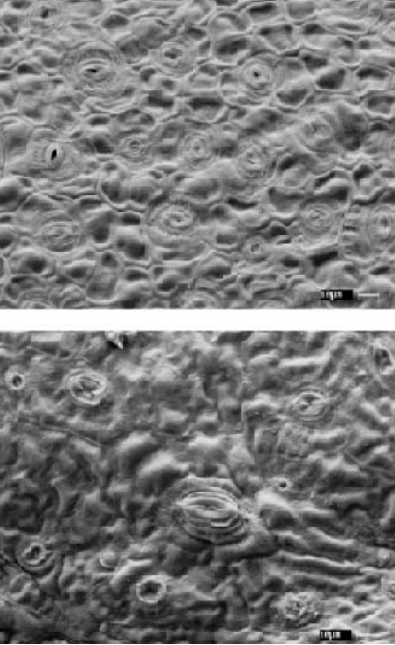
Figure 3. Abaxial leaf surfaces of coffee trees grown in sufficient (top) and deficient (bottom) B